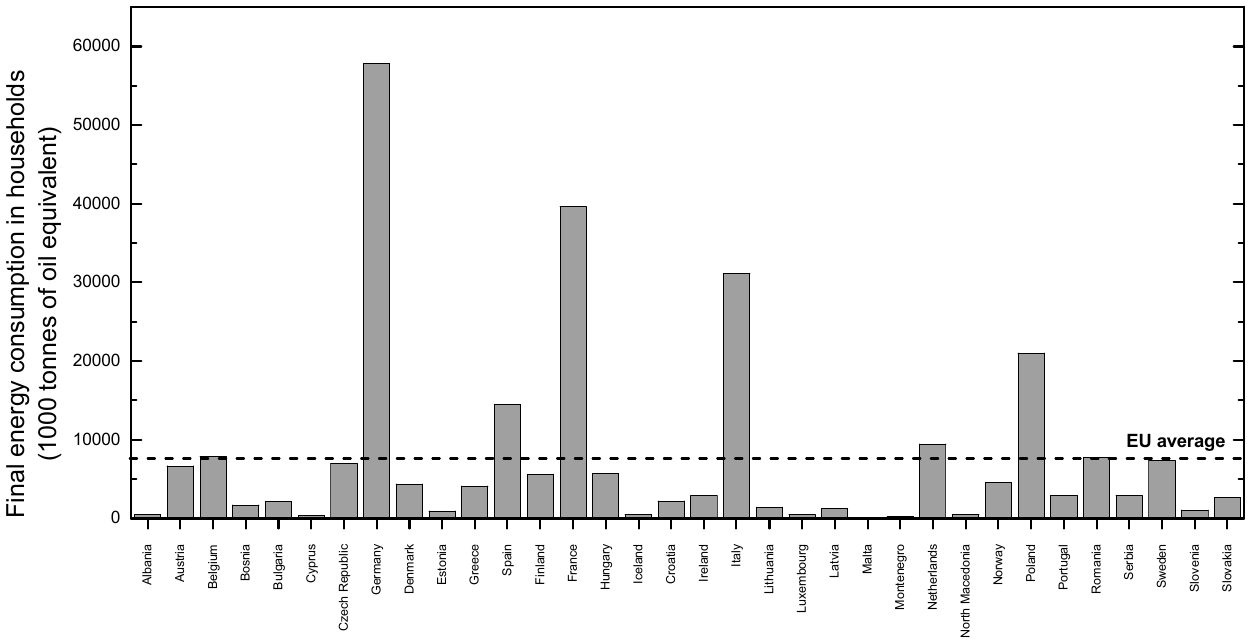
Figure 3. Final energy consumption in households in 2020 (Sources: EU Buildings Factsheets).